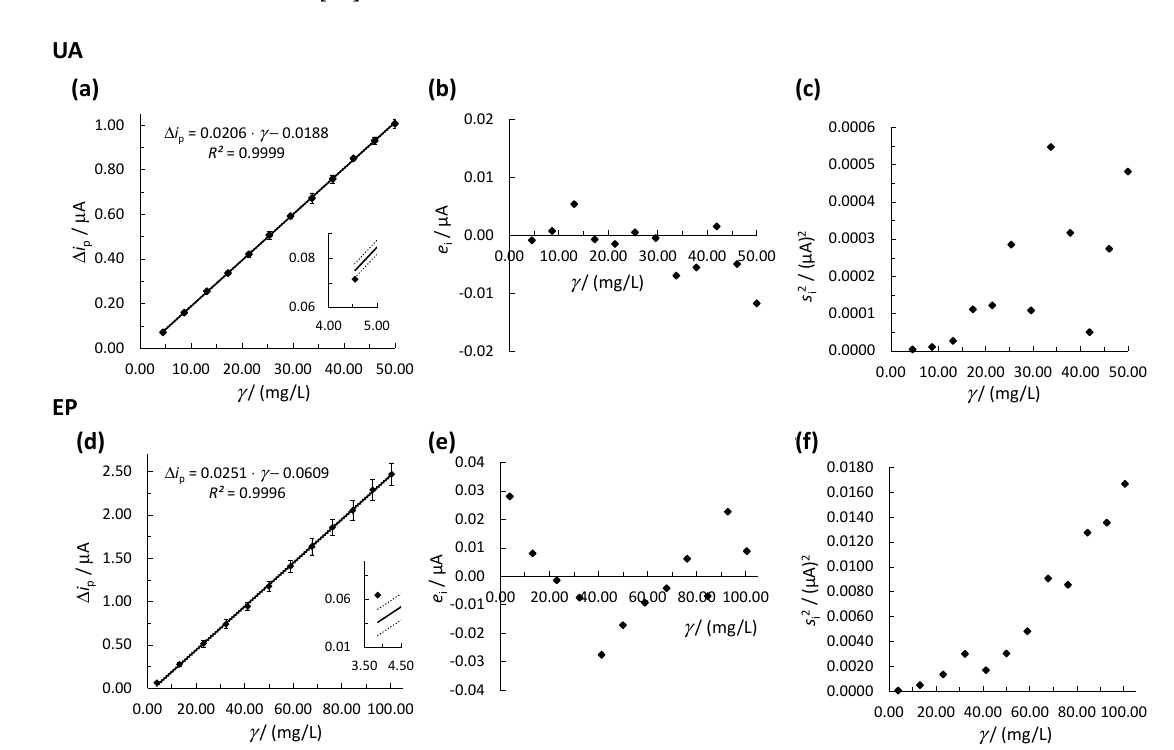
Figure 2. Linear concentration ranges for ( a ) UA and ( d ) EP using the OLS method, where the solid line represents the calibration curve and the dotted lines represent the upper and lower 95% confidence intervals. The error bars in ( a , d ) represent the standard deviations. The inserts in ( a , d ) show the first calibration point. Plots of the residual analysis are shown in ( b ) for UA and ( e ) for EP. Plots of s 2 vs. γ are shown in ( c ) for UA and in ( f ) for EP. Measurements were performed by SPCE.